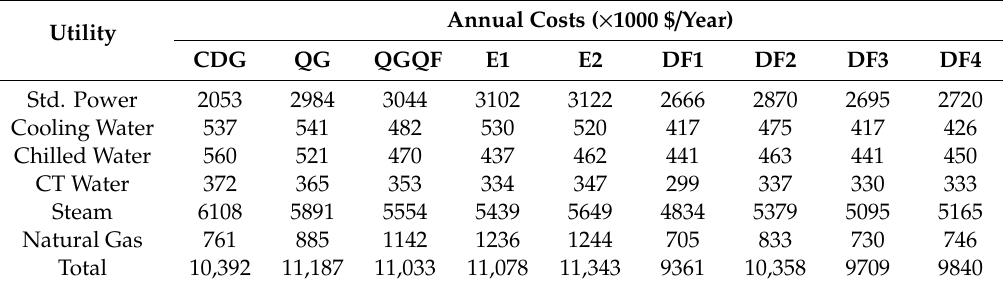
Table 4. Summary of utility costs in conventional and modified dry grind